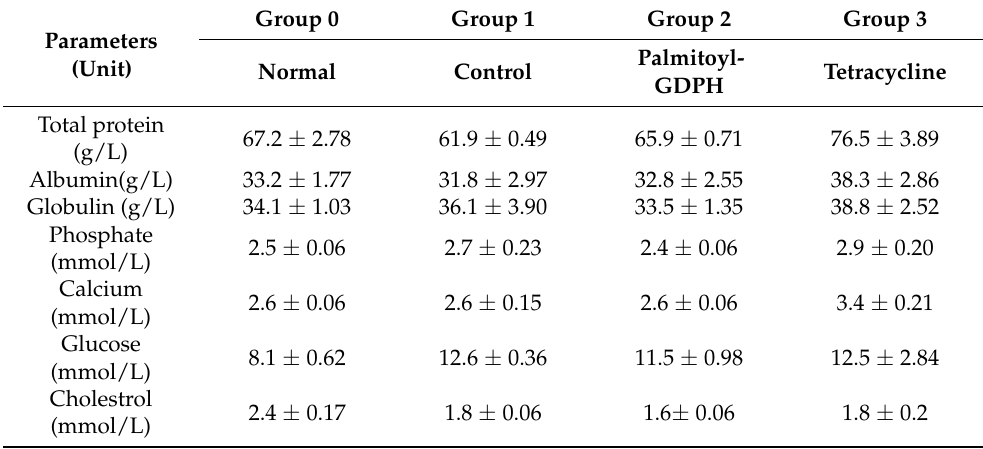
Figure 11. Hematology analysis for 3 major categories of blood cells; ( a ) red blood cells, ( b ) white blood cells and ( c ) platelets. The G0, G1, G2, and G3 represent Group 0 (normal rats), Group 1 (Control rats), Group 2 (Palmitoyl-GDPH treated rats), and Group 3 (tetracycline treated rats), respectively. * Denotes significance (versus normal group) at p < 0.05. Table 5. Chemistry analysis data for routine check-up lists in blood of protein components. Values are expressed as mean ±